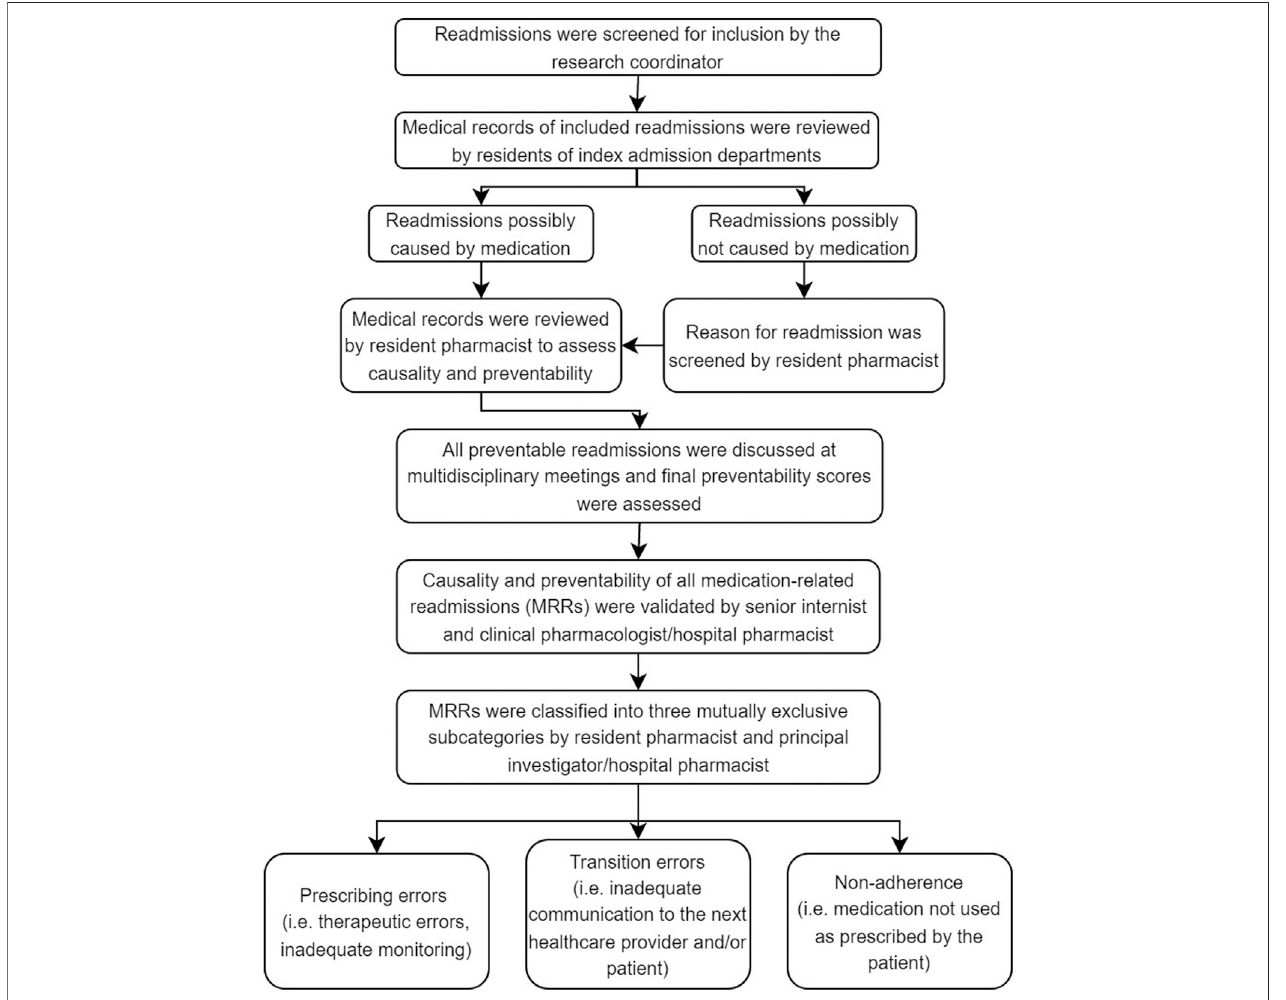
FIGURE1| Process ofcausality and preventabilityassessmentsofreadmissions (Uitvlugt et al.,2021; vanden Bemt and Egberts 2007;van der Doeset al., 2020; Warlé-van Herwaarden et al., 2015). Prescribing errors were de fi ned as medication errors, among others, dosing errors, contra-indications, drug interactions, omission errors or overdosing. Non-adherence was de fi ned as a re fi ll rate lower than 0.8. The re fi ll rate was calculated by dividing the number of daily doses dispensed with the totalnumberofdaysbetweenthe fi rstandlastprescriptioninaperiodof8monthsbeforereadmission.Anadmittingmedicaldoctorassessedtherapyadherenceif the re fi ll rate could not be calculated. If the admitting doctor mentioned a patient of being non-adherent, the patient was classi fi ed as such.